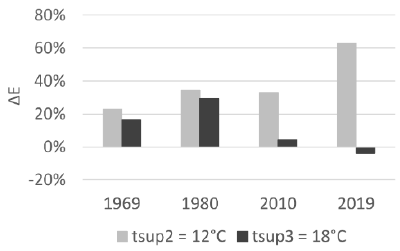
Figure 14. Relative energy for air treatment.